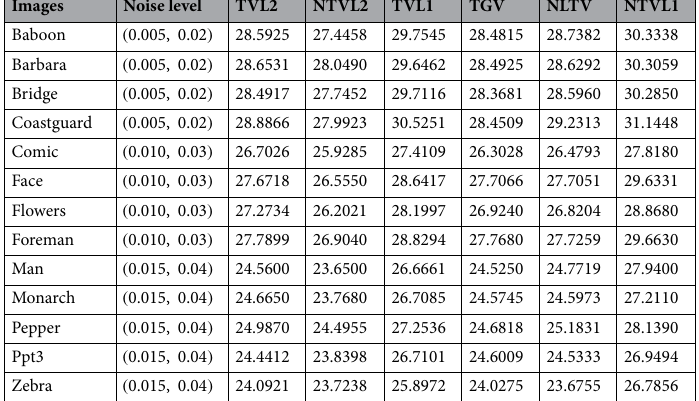
Table 6. The PSNR of the restored images in